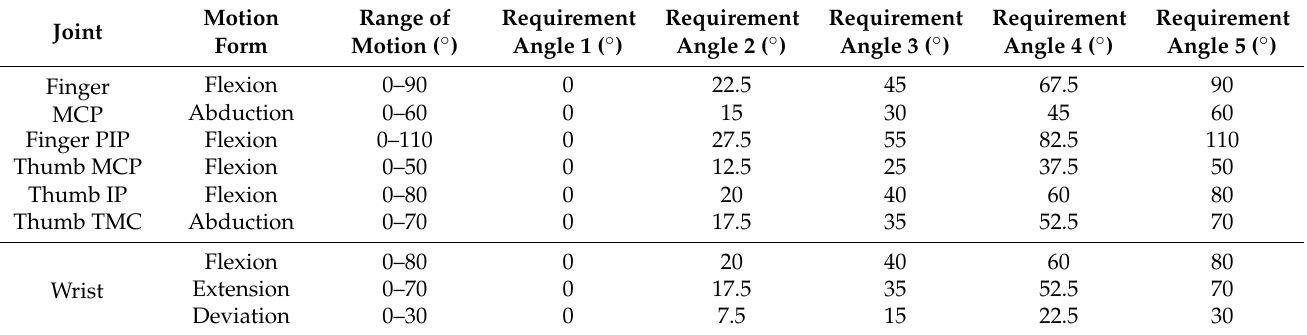
Table 4. Mean and standard deviation of Leap Motion measurement results.